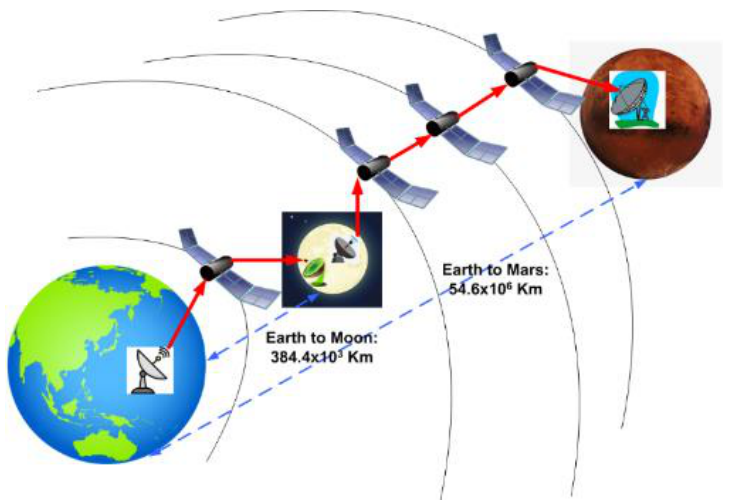
Figure 28. The FSO in the configuration of deep-space optical relaying networks (DSORN) as the communication platform between Earth to Mars.